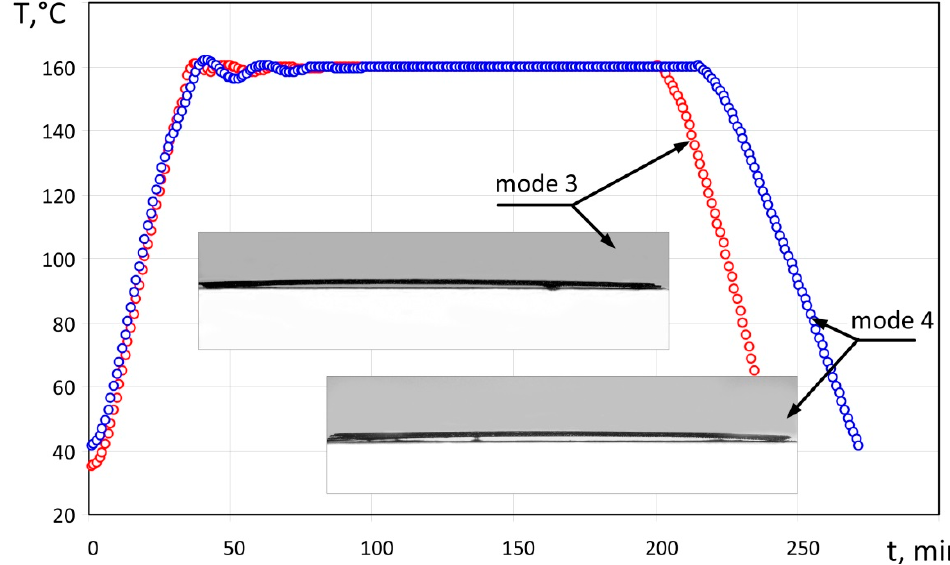
Figure 7. Moulding modes No. 3 and No. 4, and specimens obtained with the use of these modes.